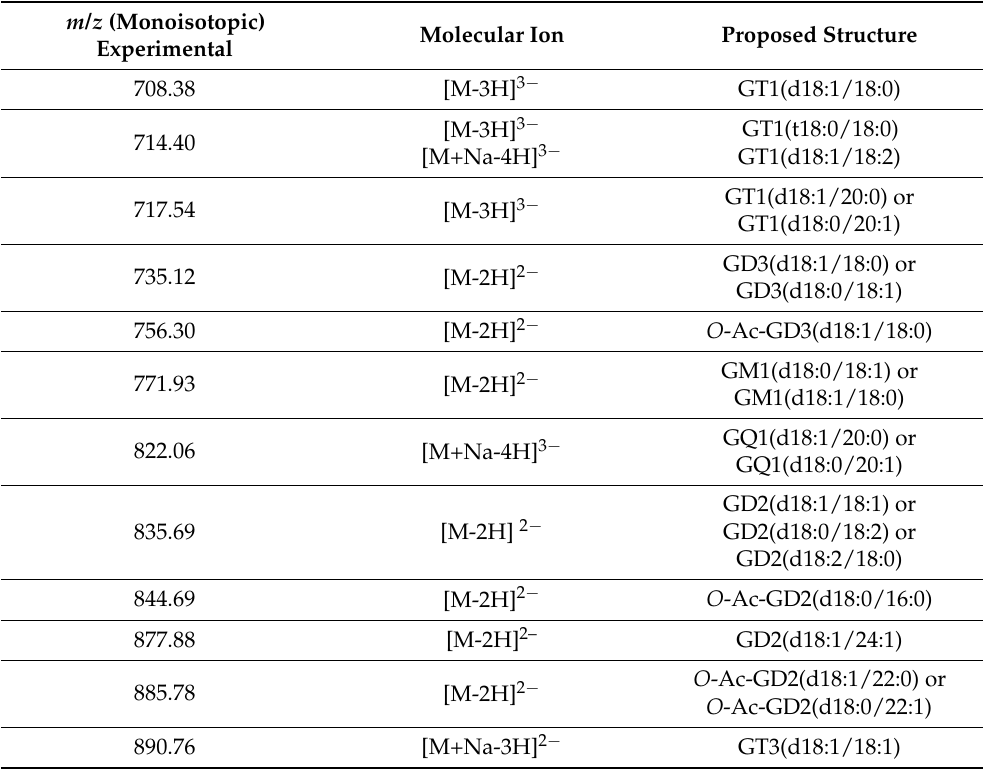
Table 5. GG and asialo-GG species from normal brain detected by (-) chip-nanoESI QTOF MS analysis of the native GG extract (adapted with permission from